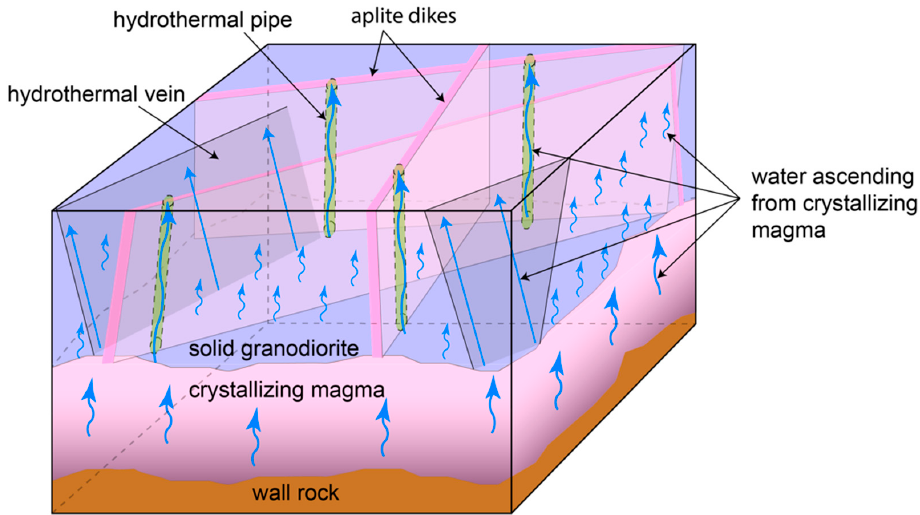
Figure 2. Schematic diagram illustrating fluid ascent paths in a growing pluton. The pluton is assumed to grow and to crystallize downward from its roof (not shown). Aplite dikes are fed by felsic melt that accumulates at the top of the active magma body [4,5].